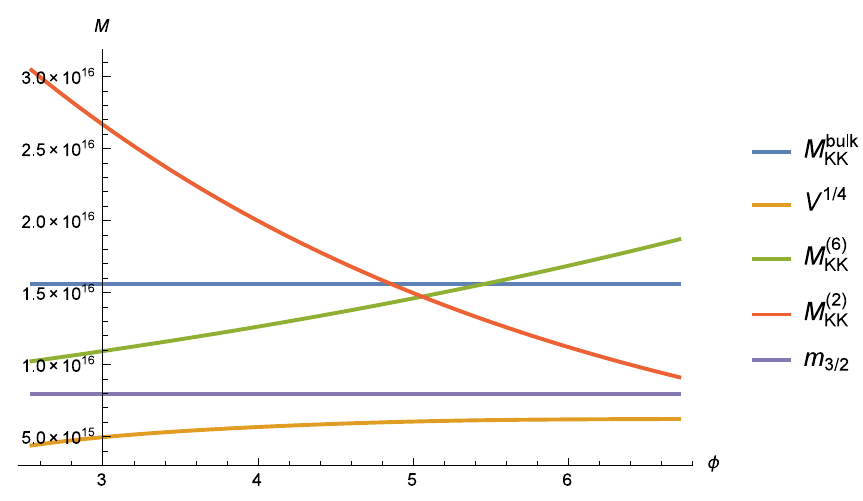
Figure 4 . Comparison between the different KK masses, the gravitino mass m tionary energy V 1 / 4 from horizon exit to the end of inflation. Note that M (4) only one of them is displayed